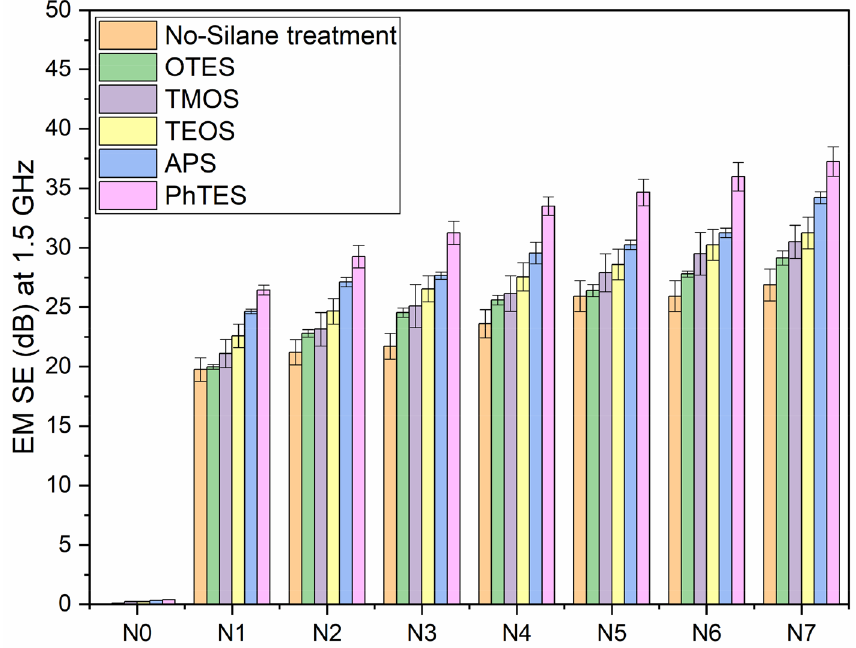
Figure 5. Silinization treatment on EM SE of Ni/Cu coated polyester fibrous